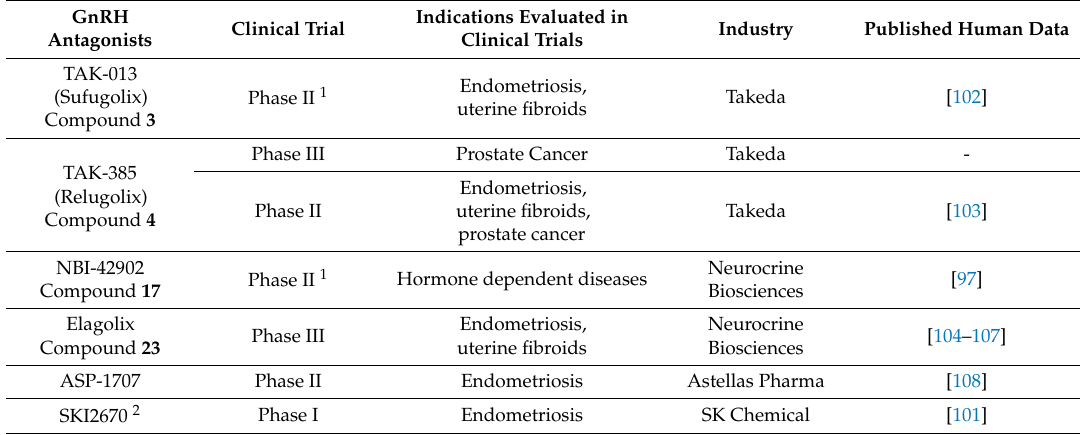
Table 14. Non-peptide GnRH antagonists in clinical